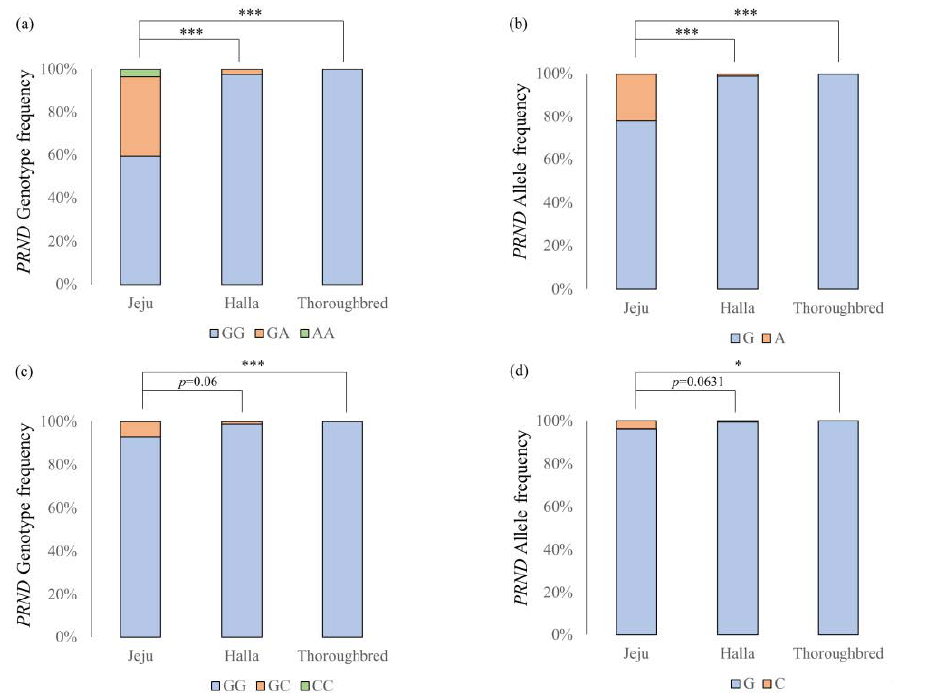
Figure 2. Comparisons of genotype and allele frequencies of horse prion-like protein ( PRND ) gene SNPs between Jeju, Halla, and Thoroughbred horses. ( a ) Comparison of the genotype frequencies of the PRND c.331G > A (A111T) polymorphism between Jeju, Halla, and Thoroughbred horses. ( b ) Comparison of the allele frequencies of the PRND c.331G > A polymorphism between Jeju, Halla, and Thoroughbred horses. ( c ) Comparison of the genotype frequencies of the PRND c.411G > C polymorphism between Jeju, Halla, and Thoroughbred horses. ( d ) Comparison of the allele frequencies of the PRND c.411G > C polymorphism between Jeju, Halla, and Thoroughbred horses. Statistically significant di ff erences are indicated below. *: p value < 0.05, ***: p value < 0.001. Table 1. Genotype and allele frequencies of the PRND c.331G > A polymorphism in Jeju, Halla, and Thoroughbred horses.